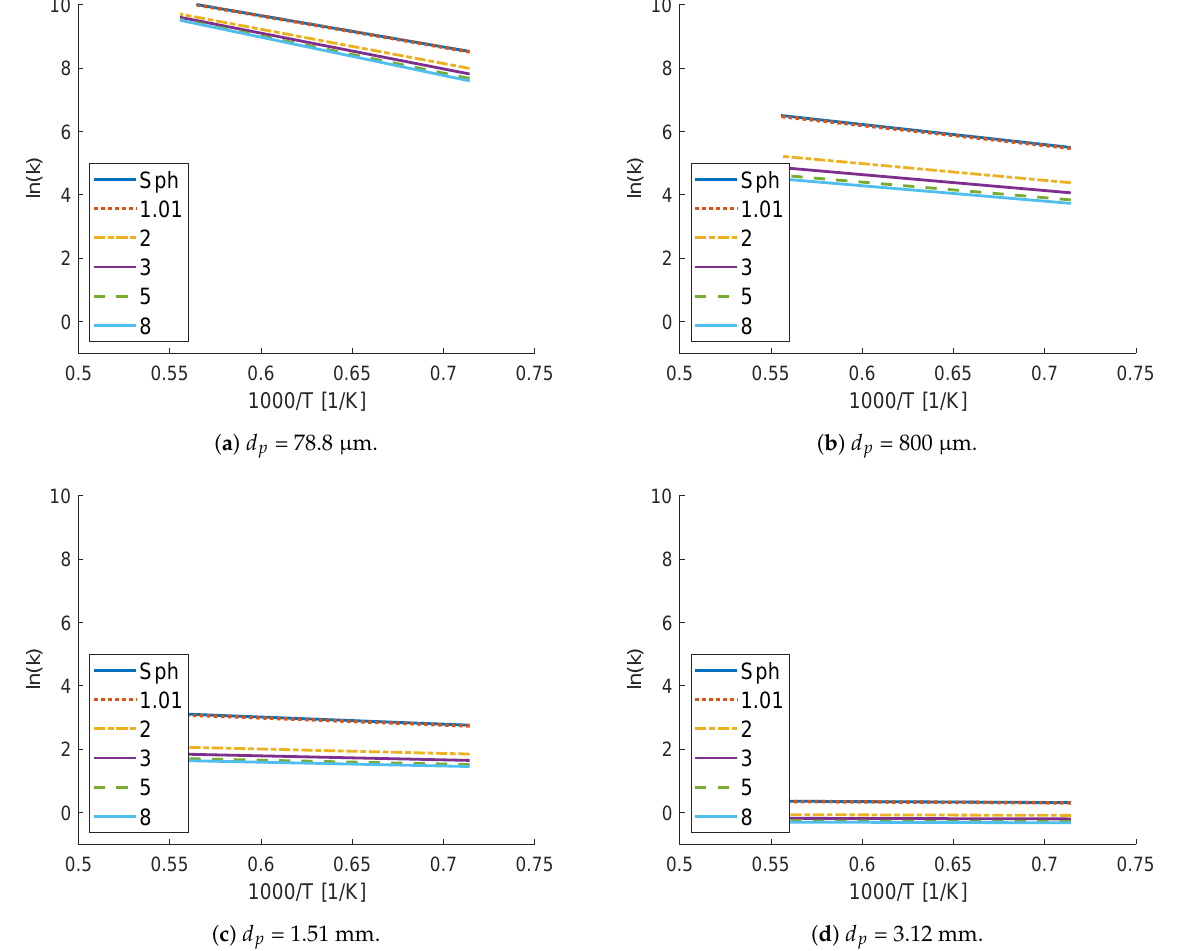
Figure 5. Arrhenius plots for the fitted values for A and E a for different aspect ratios for four particle sizes, ρ = 700 kg/m 3 , T g = 1600 K. The Arrhenius parameters have been used to generate Arrhenius plots for a smaller temperature interval to illustrate the effects of the input